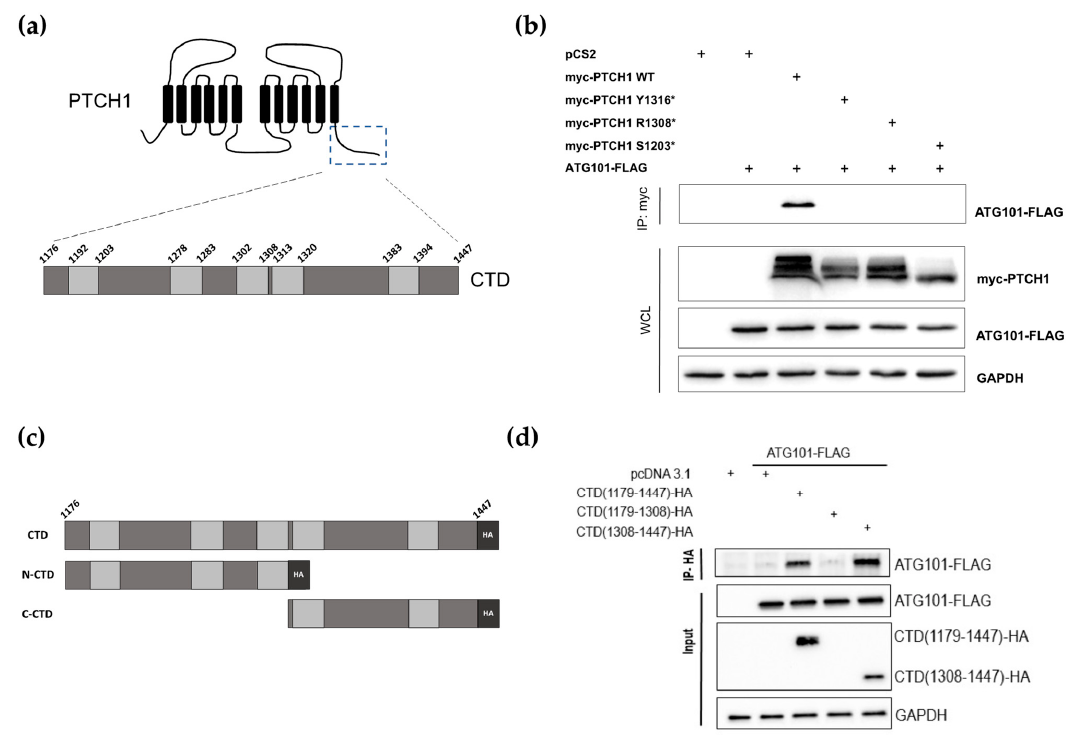
Figure 1. Identification of the ATG101 binding region in PTCH1. ( a ) Schematic representation of PTCH1 topological domains. The specific residues delimitating each proline-rich domain (light grey rectangles) in the C-terminal domain (CTD) are indicated in the zoomed region. ( b ) Co- immunoprecipitation of ATG101-FLAG with myc-tagged wild-type or indicated truncated mutants of PTCH1 from HEK293 cells. ( c ) Schematic representation of the isolated PTCH1 CTD construct (HA-tagged) and the two halves used in ( d ). ( d ) Co-immunoprecipitation of ATG101-FLAG with full-length CTD (1179–1447) and the C-terminal half of the CTD (1308–1447) when overexpressed in HEK293 cells. All experiments are representative of a minimum n = 3. All the whole western blot figures can be found in the supplementary materials. 3.3. Cancer-Associated PTCH1 CTD Truncation Mutants Lack Autophagy Inhibitory Activity Next, we investigated whether the inability of the PTCH1 CTD mutants to associate with ATG101 could lead to impairment of PTCH1 ′ s role to repress autophagic flux. During completion of autophagy, autophagosome-localised LC3B-II and the ubiquitylated cargo adaptor p62/SQSMT1 are degraded along with the cargo. Inhibition of lysosomal hydrolases or autophagosome-lysosome fusion results in a large accumulation of LC3B-II and p62 when autophagic flux is high and in a smaller accumulation of both markers when the autophagic flux is slow or blocked [15]. We have previously used the inhibitors bafilomycin A1 (BafA1) and chloroquine to demonstrate that overexpressed or endogenous PTCH1 functions inhibit autophagic flux [5]. To determine whether the CTD truncation mutants are defective in autophagy inhibitory activity, we followed the changes in LC3B-II and p62 in HEK293 cells expressing myc-tagged wild-type PTCH1(1-1447), PTCH1(1-1203), PTCH1(1-1308), or empty vector in the absence or presence of BafA1 during the last 4 h. As shown in Figure 2a,b, none of the three PTCH1 truncations reduced autophagic flux, unlike wild-type PTCH1(1-1447). This result was expected since they cannot interact with ATG101.